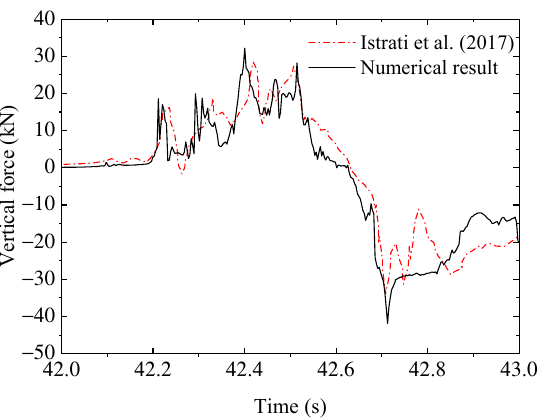
Figure 10. Comparison of the time histories of the vertical force between the numerical result of current study and the experimental result of Istrati [38].